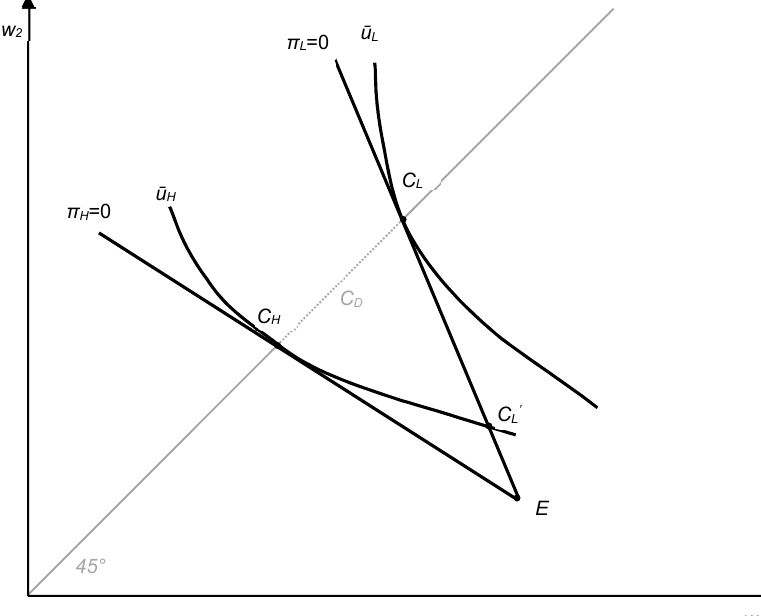
Figure 3. Market equilibrium after the introduction of the C D contract.